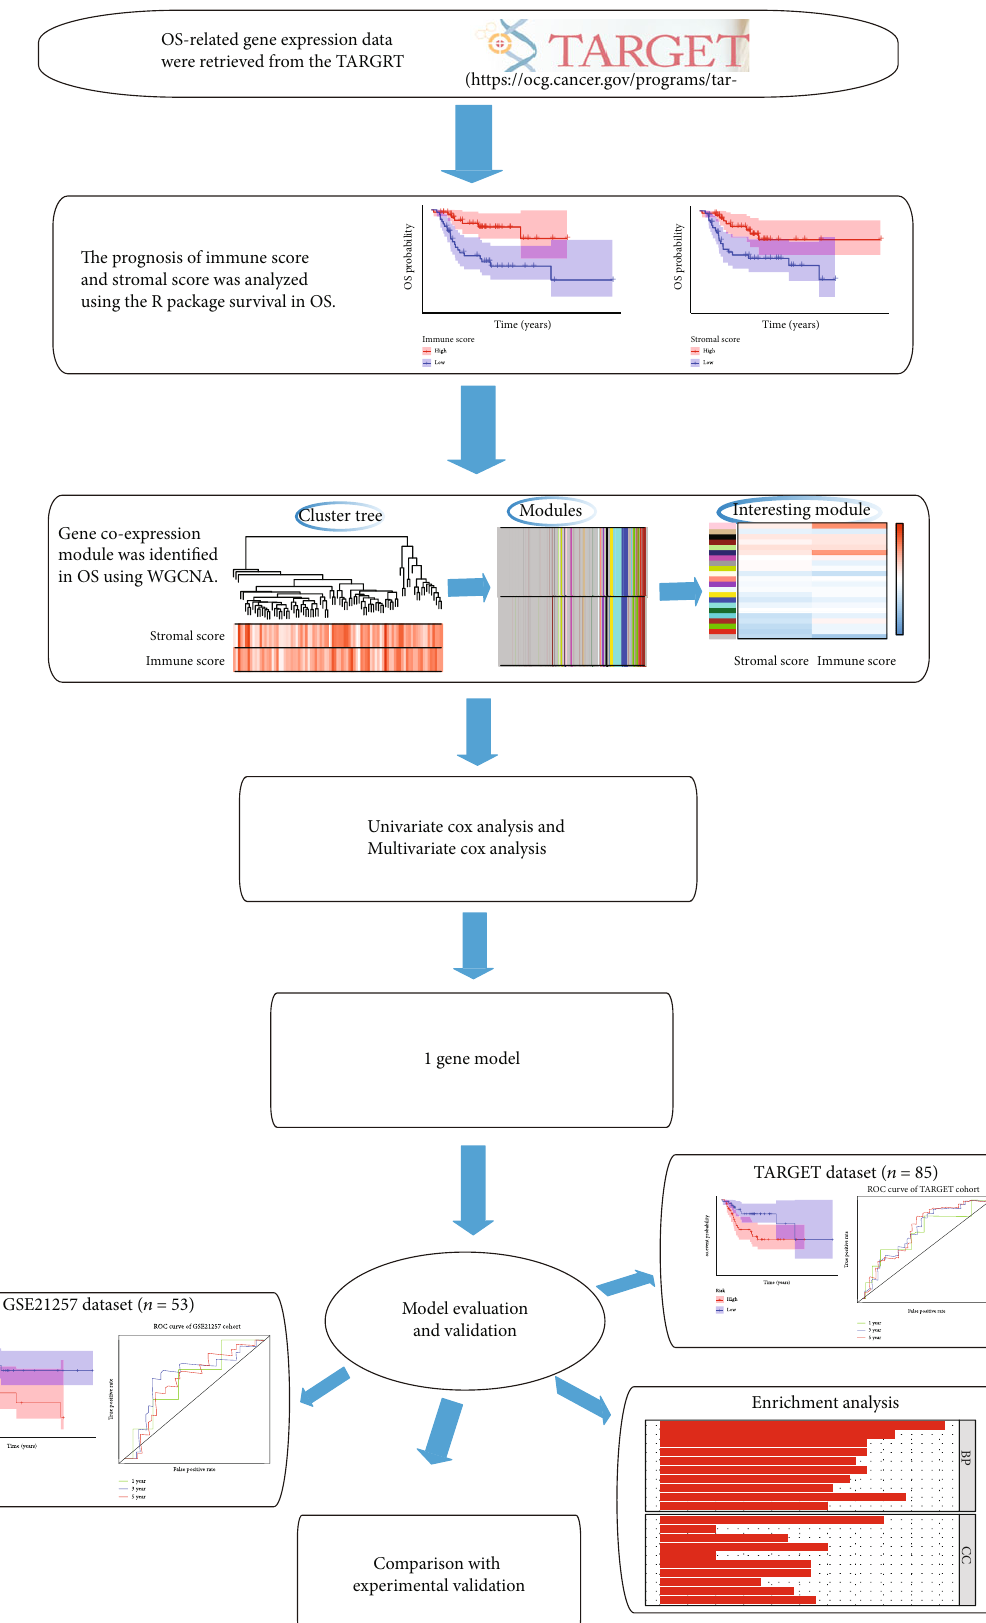
model(https://ocg.cancer.gov/programs/tar-OS-related gene expression data were retrieved from the TARGRT